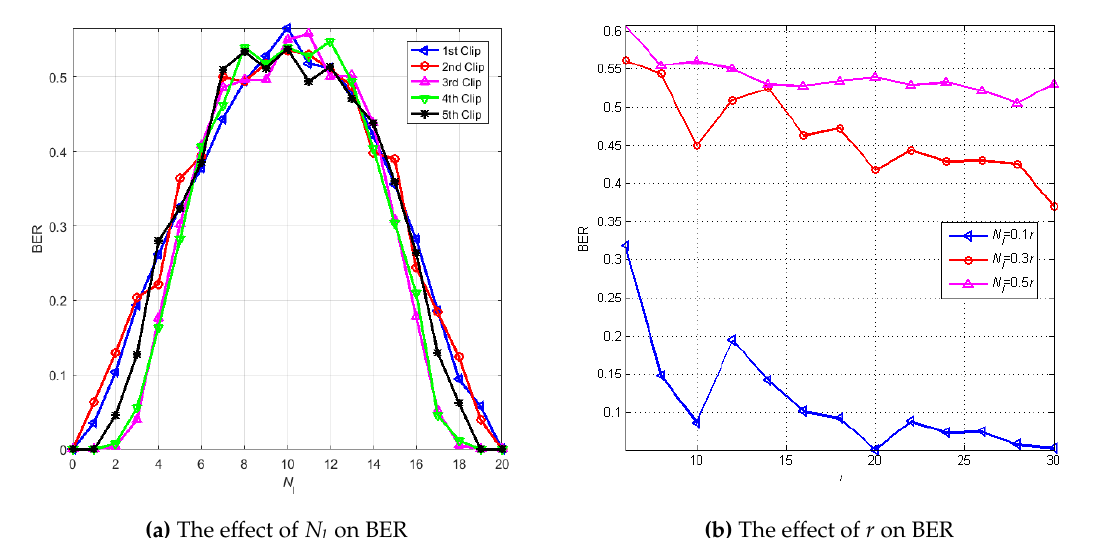
Figure 6. BER in relation to N l and r using a different Hadamard matrix between encoding and